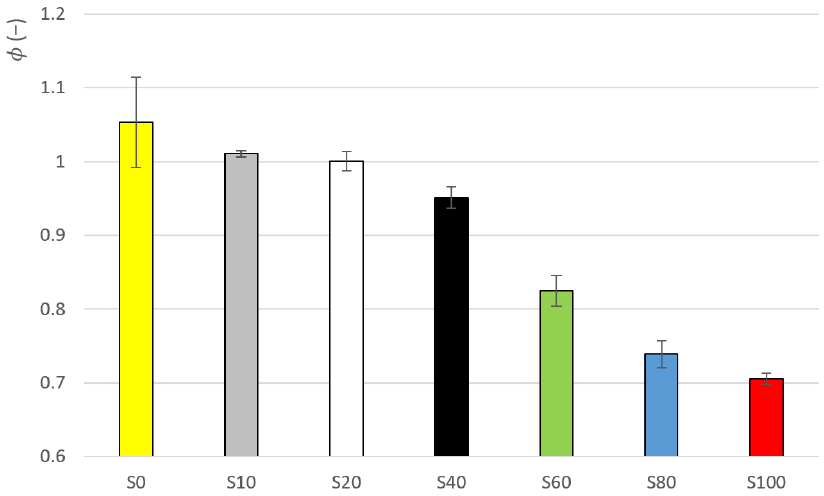
Figure 6. Parameter (cid:2038) average values for samples S0–S100. Table 4. Exploratory data analysis of the (cid:2038) values.